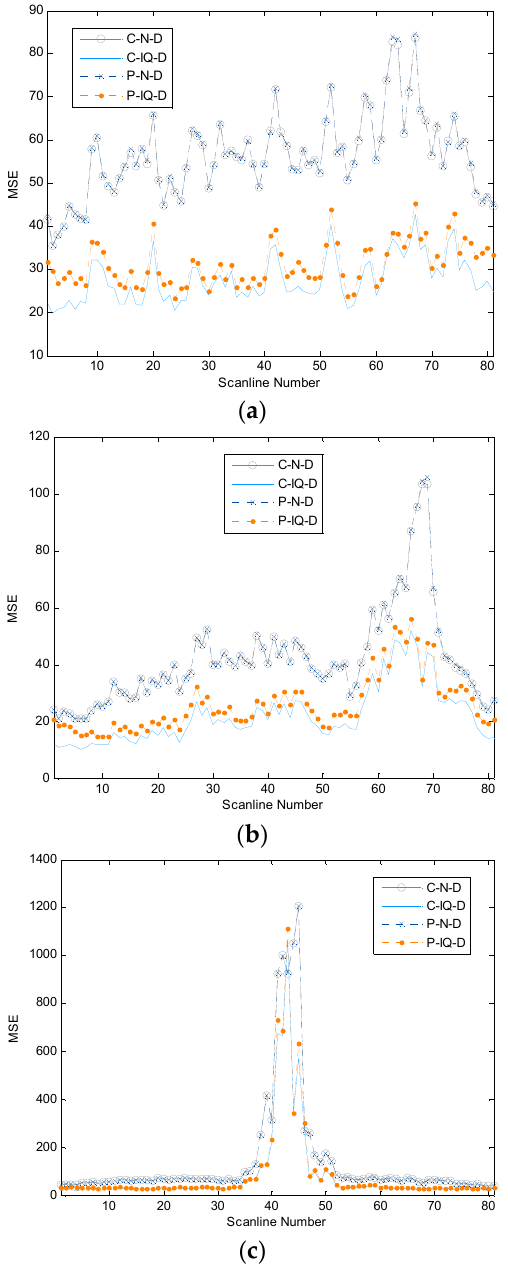
Figure 6. MSEs of all scanlines between the reference beamformed signals and the signals beamformed using four different schemes, conventional (C)-nearest sample (N)-double precision floating format (D), C- in-phase/quadrature (IQ)-D, proposed (P) method-N-D and P-IQ-D. The figures are from Experiments 1 to 3 ( a – c ), respectively.